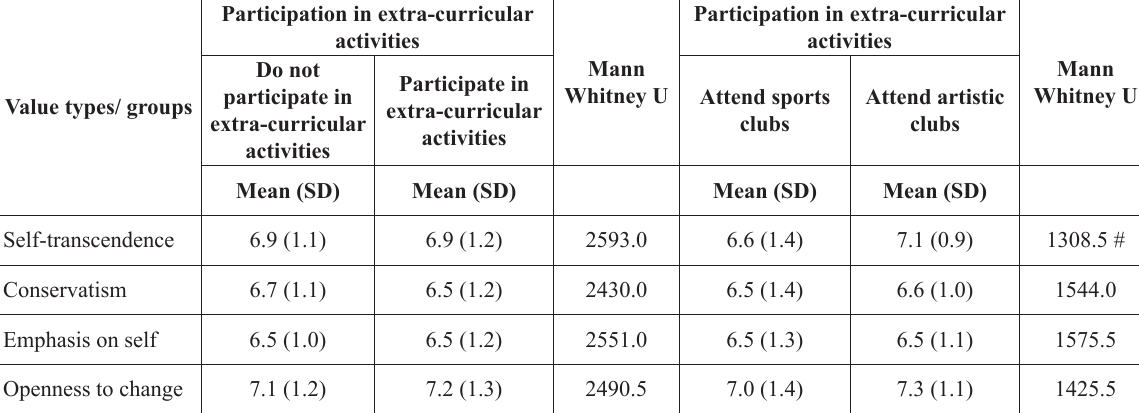
Table 3. Differences in the importance of higher range values groups according to participation in extra–curricular activity and its type